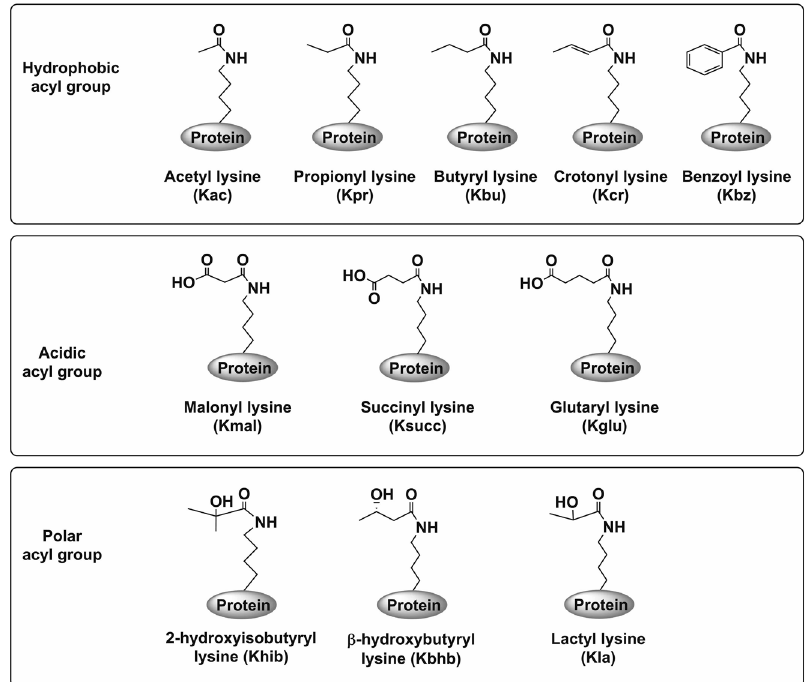
Fig. 1 Chemical structures of lysine acylations. Based on their chemical properties, lysine acylations are classi fi ed into three groups: the hydrophobic acyl group that extends hydrocarbon chains, including Kac, Kpr, Kbu, Kbz, and Kcr; the polar acyl group includes Kbhb, Khib, and Kla that contain hydroxyl moiety to enable the modi fi ed lysine to form hydrogen bonds with other molecules; the acidic acyl group includes Kmal, Ksucc, and Kglu that alter the charge at the lysine residue from + 1 to – 1 at physiological pH [1].